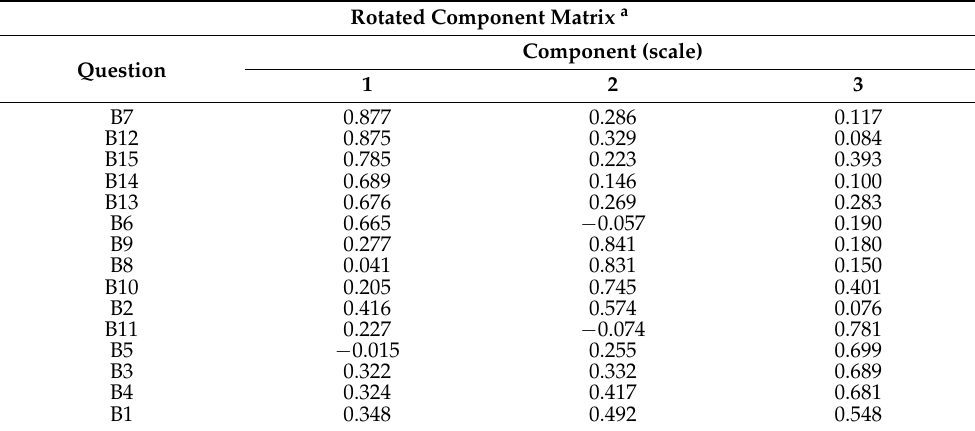
Table A6. The rotated component matrix yielded by EFA to generate three scales of questions of the aspect of user interaction satisfaction.